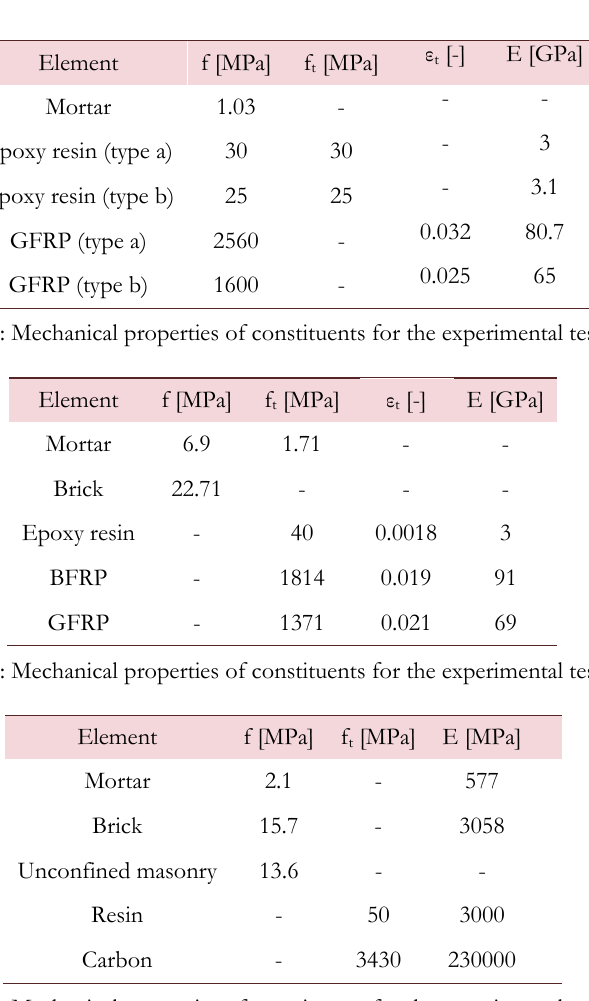
Table 3.A: Mechanical properties of constituents for the experimental tests [35].